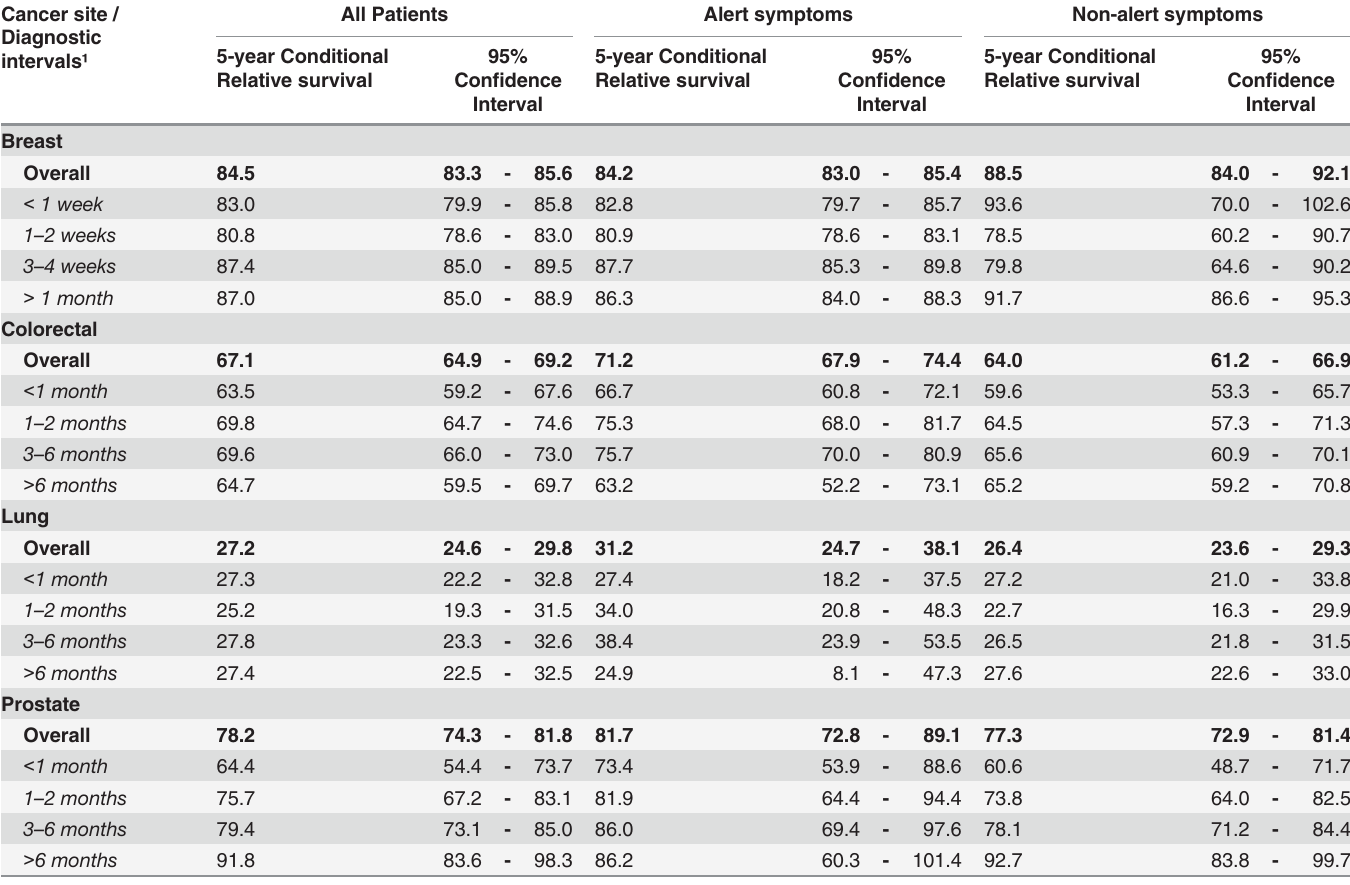
Table 5. Conditional relative survival of cancer patients by site, diagnostic interval ¹ and symptom category ²